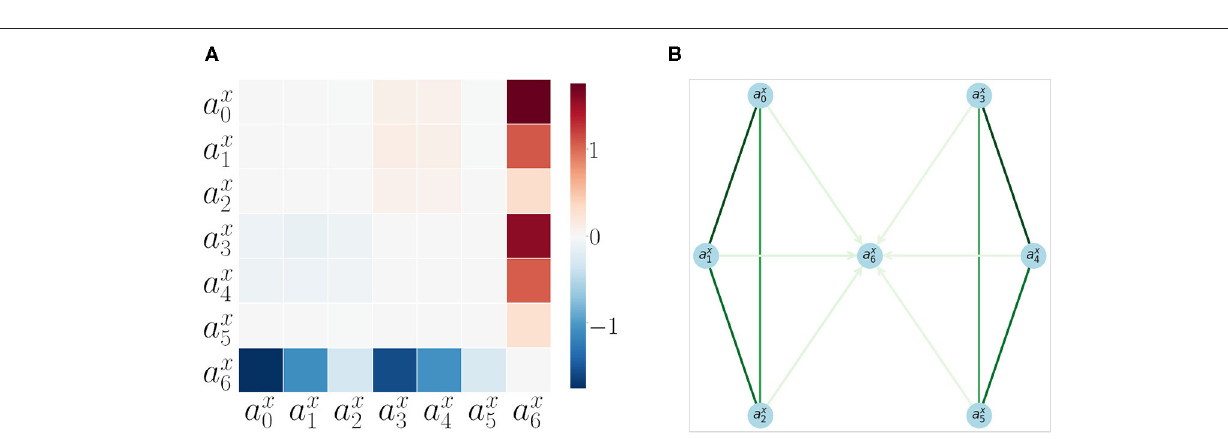
FIGURE 6 | Acceleration Transfer results (A) Matrix of pairwise AT measure values between all SIPs for all SM interaction data. (B) Directed graph of SIP accelerations a x 0 , ..., a x 6 , generated from 200 repetitions of sensorimotor interactions. The edge colors show the correlation strength between the nodes (extracted from the velocity correlation analysis, refer to section 3.1), while the arrows show the direction of AT (refer to section 3.2). Only arrows with a significant AT are plotted. Take note that the node a x 6 is the only terminal node, as it can not accelerate by itself and depends on the AT from other